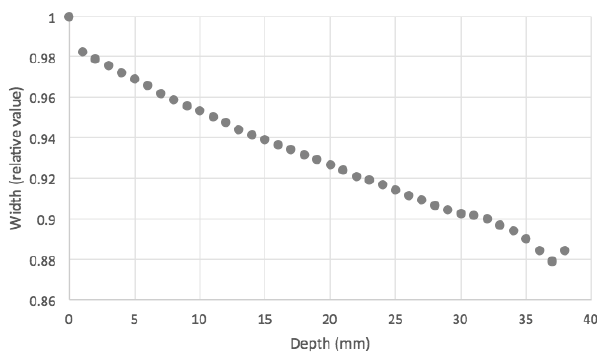
Figure 12. The apparent width of the cell as a function of the length of liquid dielectric between the UV sheet and the camera.